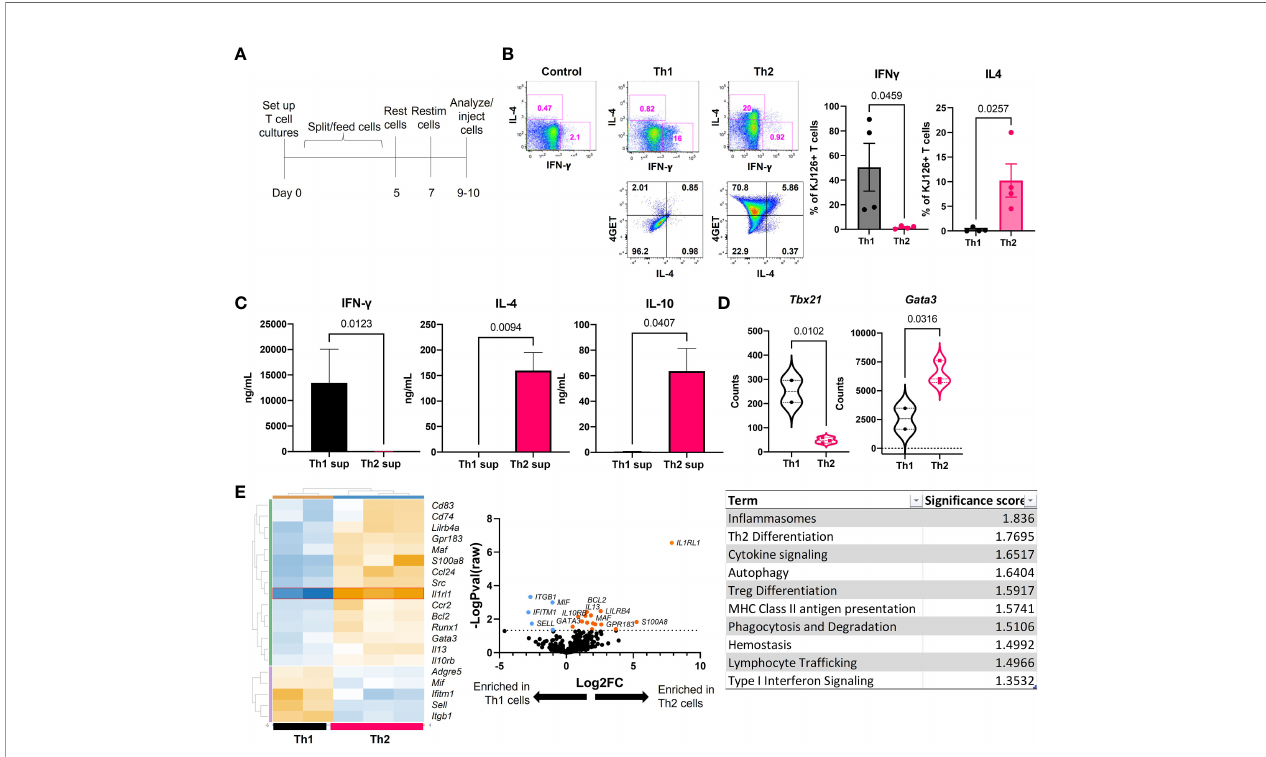
FIGURE 1 | Generation and functional phenotype of activated DO11 T cells. (A) Timeline for the generation of activated Th1 and Th2 subsets. (B) Cytokine production by the injected Th1 and Th2 cells shown by fl ow cytometric analysis of IL-4 vs IFN g (top) and GFP vs IL-4 (bottom). (C) Culture supernatants from the restimulated Th1 and Th2 cells determined by ELISA (n=5-6 Th1 and 9-11 Th2). (D) NanoString analysis of master regulator transcription factors expressed by in vitro activated T cells. (E) NanoString heatmap, volcano plot and Gene Set Analysis (GSA) of restimulated Th1 and Th2 cells analyzed by Rosalind software (n=2 Th1 and n=3 Th2 RNA samples pooled from 2 separate experiments; two-tailed student ’ s t tests signi fi cant as